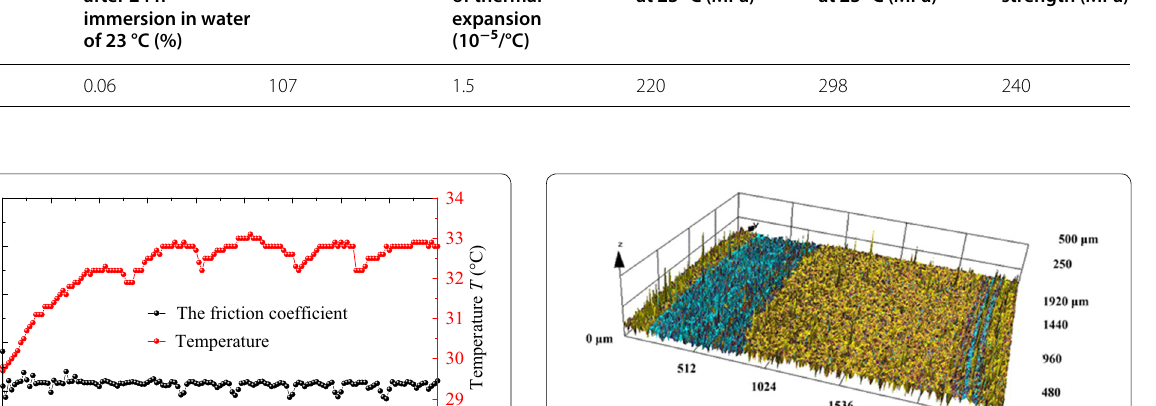
Table 3 Properties of CFRPEEK Density (g/cm 3 ) Water absorption after 24 h